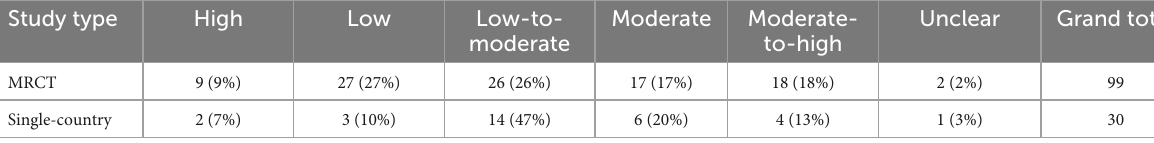
TABLE 7 Summary table for risk-of-bias for MRCTs and single-country